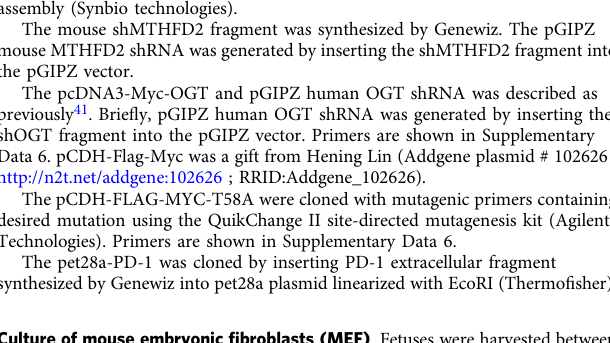
Fig. 6 MTHFD2 promotes PD-L1 transcription through cMYC O-GlcNAcylation. a The GSEA analysis of the transcriptome (as indicated in Fig. 2a) in SW1990 cells transfected with indicated siRNAs, were performed with the GeneSet “ Genes regulated in primary epithelial cell overexpressing cMYC ” in MSigDB C6 (oncogenic signatures) and with the GeneSet “ Genes having at least one occurrence of the transcription factor binding site MYC/MAX_B in the regions spanning up to 4 kb around their transcription starting sites ” in MSigDB C3 (motif) transcription factor targets database. b SW1990 cells with siMTHFD2 transfected with indicated expressing vectors, PD-L1 mRNA levels were analyzed by real-time PCR. c SW1990 cells with siMTHFD2 treated with 0.3 mM UDP or 0.6 mM UTP for 24 h, immunoblotting analyses were performed using the indicated antibodies. d Analysis of the apparent half-life time of wild type and mutant cMYC in cycloheximide treated cells transfected with indicated vectors. e , f The cell lysates of SW1990 cells expressing WT or T58A Flag-cMYC with indicated plasmid ( e ) or siRNA ( f ) were subjected to immunoprecipitation with an anti-Flag antibody, and the precipitates (loading volume adjusted to be equal precipitated cMYC) and whole lysates (equal total protein amount loading) were analyzed by immunoblotting using indicated antibodies. g , h SW1990 cells expressed with WT or T58A Flag-cMYC transfected with indicated siRNAs, were treated with 0.3 mM UDP or 0.6 mM UTP for 24 h. PD-L1 mRNA levels were analyzed by real-time PCR ( g ); cell lysates were subjected to immunoprecipitation with an anti-Flag antibody, and the precipitates (loading volume adjusted to be equal precipitated cMYC) and whole lysates (equal total protein loading) were analyzed by immunoblotting using indicated antibodies ( h ). In ( b ) and ( g ), the values are presented as mean ± s.e.m ( n = 3 independent experiments); p values (Student ’ s t test, two-sided) with control or the indicated groups are presented (also see Supplementary Fig.